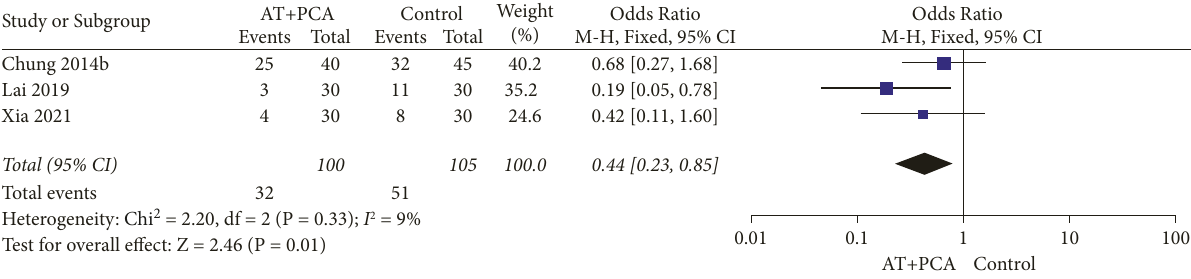
Figure 5: Forest plots of the incidence of postoperative PCA-related total complications. AT: acupuncture.